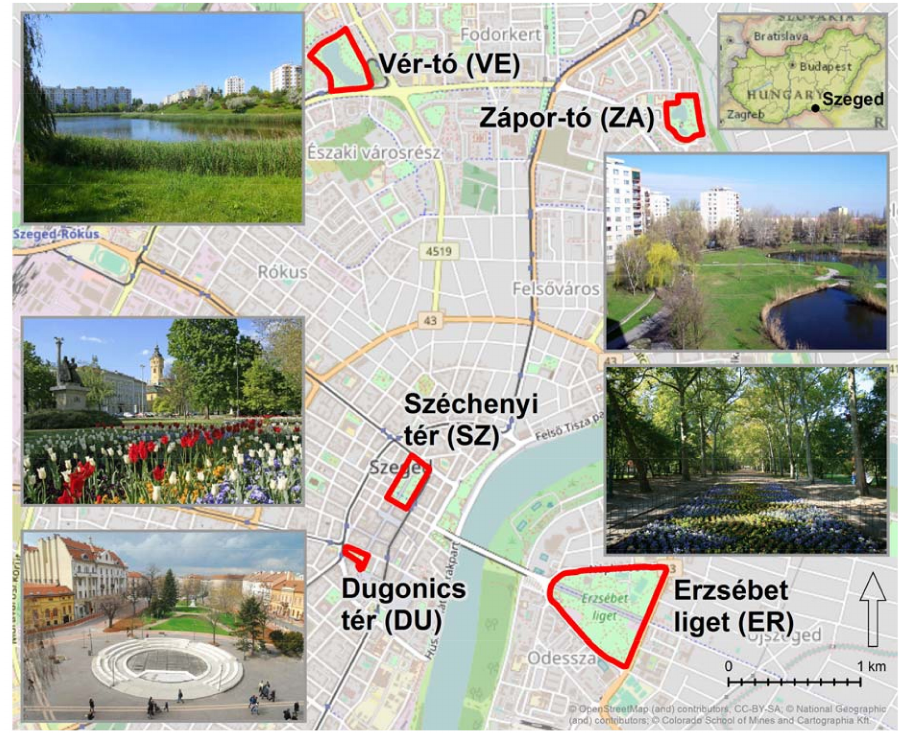
Figure 1. Location of the study areas. Figure created by the authors. Sources of base maps: